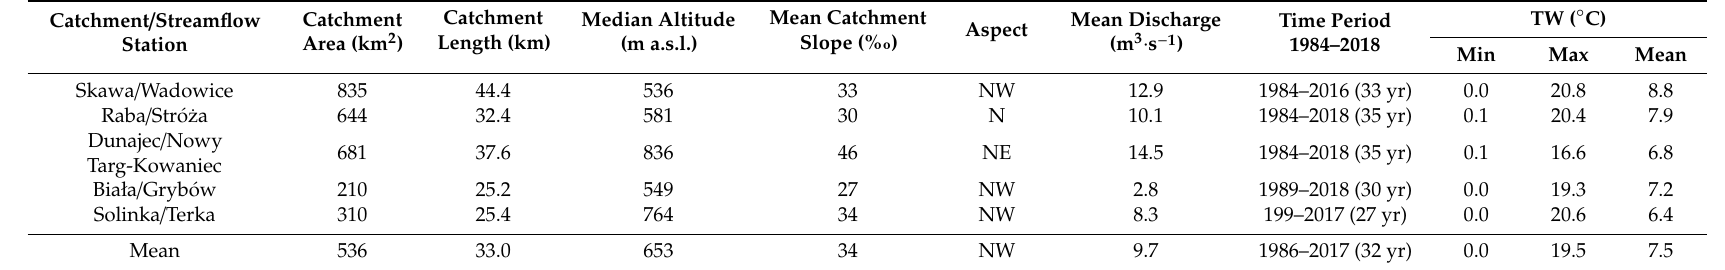
Table 1. Physiographic characteristics of the studied river catchments [26], and monthly water temperature (TW) characteristics. Catchment / Streamflow